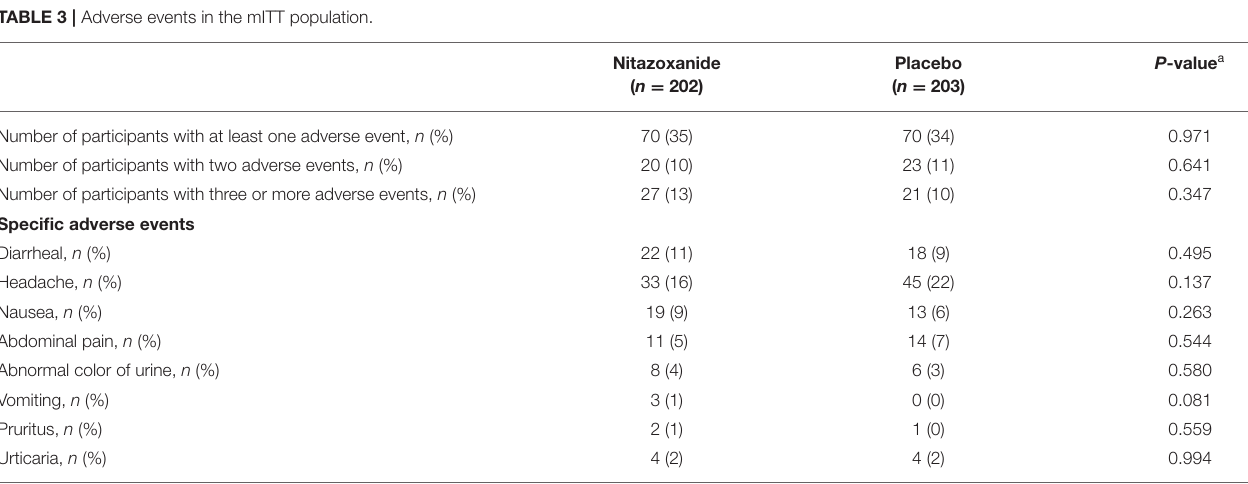
TABLE 3 | Adverse events in the mITT